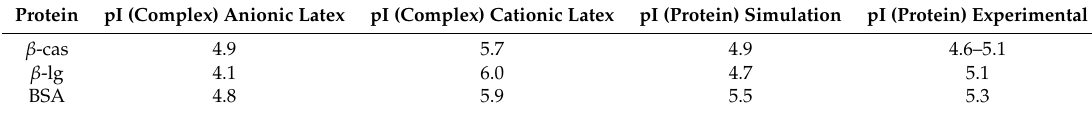
Figure 8. Electrophoretic mobility ( µ e ) measurements as a function of pH of the protein-coated latex complexes formed with the three proteins and ( a ) anionic latex and ( b ) cationic latex. We also show the mobility for the bare latexes without adsorbed protein for a reference. The solid lines are guides to the eye. Table 3. Isoelectric point (pI) of the protein-latex complexes as obtained from the electrophoretic measurements reported in Figure 8. For comparison, we also include the pI obtained by simulation and the experimental pI of each protein reported in Table